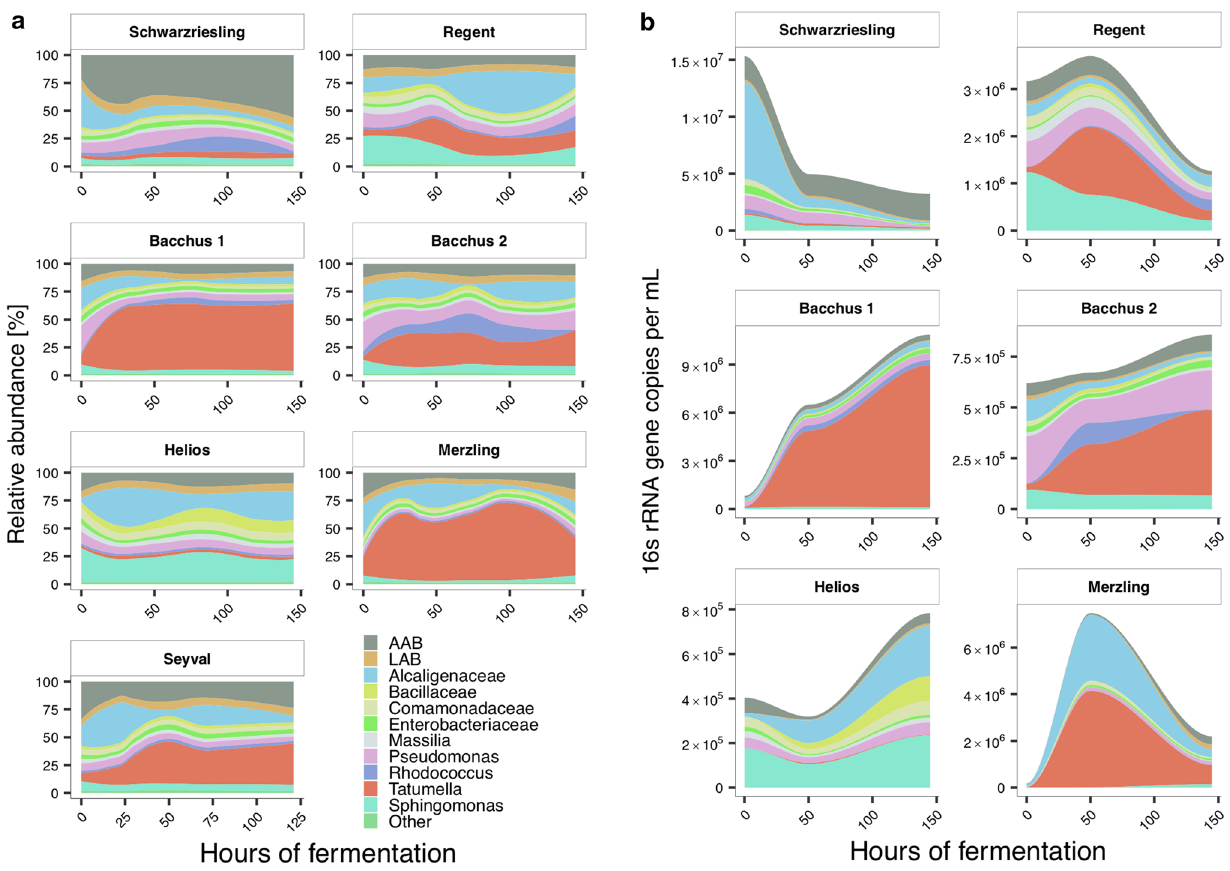
Figure 3. Relative ( a ) and absolute ( b ) bacterial microbiota composition changes during fermentation. For the visualization an abundance threshold was set of either ≥ 1% in all samples or ≥ 5% in at least one sample. The eleven most abundant assigned taxa on the genus level are shown in the figure. Locally weighted regression was used to smooth relative abundances over